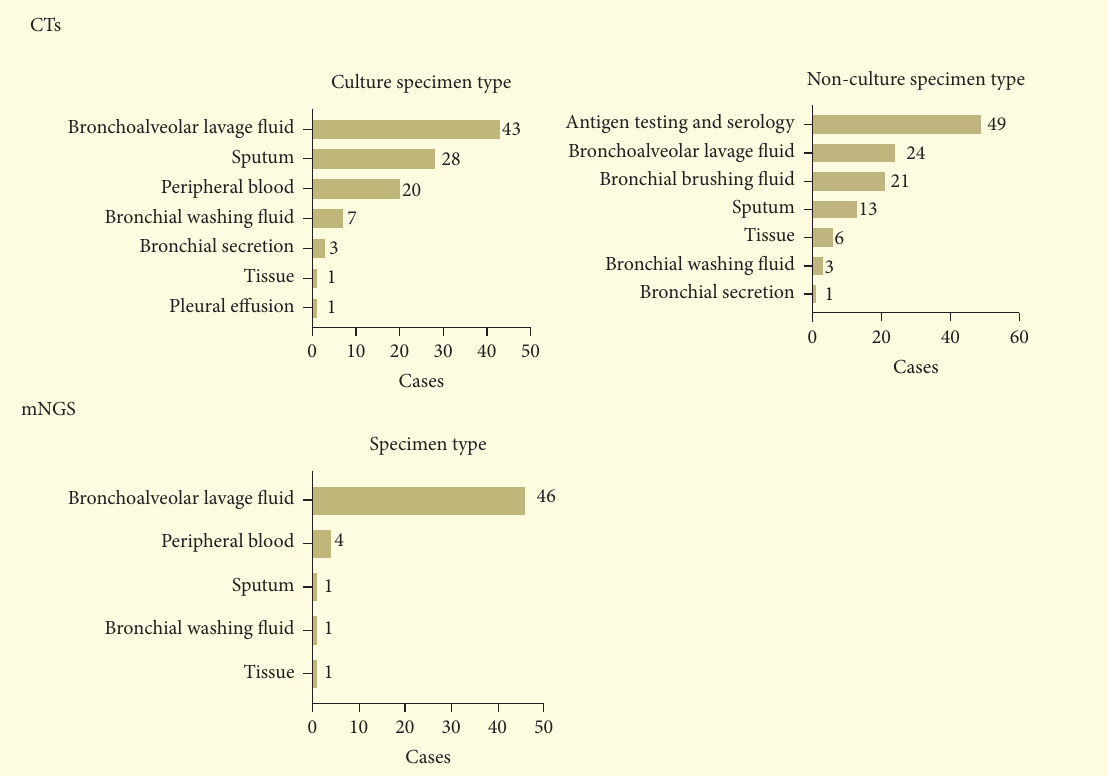
Figure 2: Distribution of sample types in CTs and mNGS. CTs were divided into culture and nonculture group. In the culture group, a total of 103 samples were collected from 43 bronchoalveolar lavage fuid, 28 sputum, 20 peripheral blood, 7 bronchial washing fuids, 3 bronchial secretions, 1 tissue, and 1 pleural efusion. In the nonculture group, a total of 117 samples were included: 49 antigen testing and serology, 24 bronchoalveolar lavage fuid, 21 bronchial brushing fuid, 13 sputum, 6 tissue, 3 bronchial washing fuid, and 1 bronchial secretion. A mNGS test was collected from 46 bronchoalveolar lavage fuid, 4 peripheral blood, 1 sputum, 1 bronchial washing fuid, and 1 tissue. CTs: comprehensive conventional pathogen